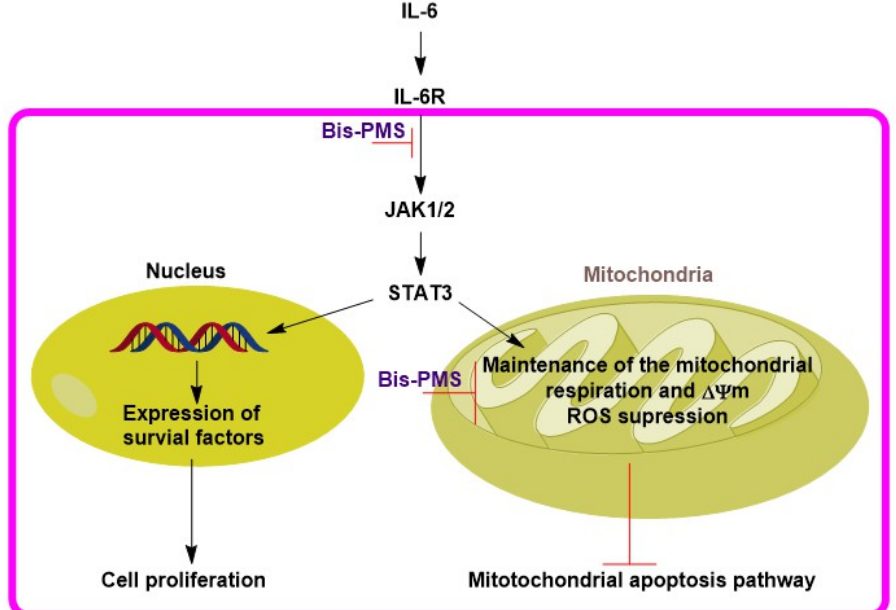
Figure 8. Proposed anticancer mechanism for Bis ‐ PMSs 5 and 6 . Decreased activity of IL ‐ 6R via IL ‐ 6R β (gp130) targeting may cause lower levels of activated/phosphorylated STAT3. The decrease in STAT3 activity reduces expression of survival factors and mitochondrial functionality. As a result, cell proliferation is repressed and the mitochondrial apoptotic pathway is activated, respectively. Simultaneously, direct inhibition of mitochondrial metabolism by Bis ‐ PMSs 5 and 6 leads to decreased cell growth and cell death.